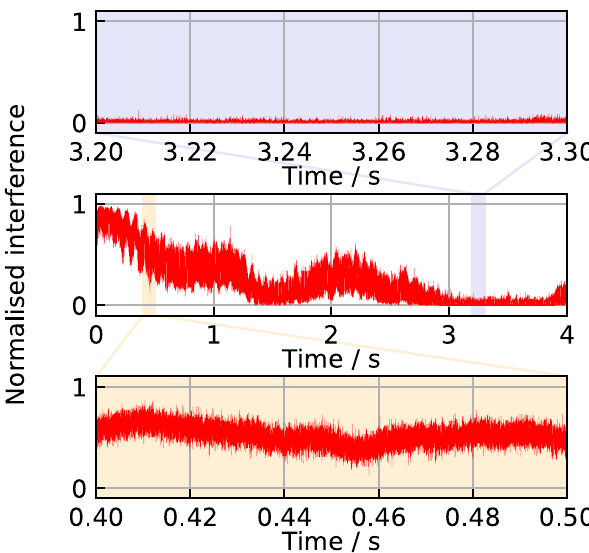
Fig. 5 QKD lasers interference on the long term. In the central panel, the normalized interference pattern in the stabilized- fi ber condition is shown in a 4 s-long time window. The shadowed area zoomed in the uppermost panel indicates a 100 ms-long fraction of the time interval in which the interferometer operated in the maximum visibility condition, i.e., the one exploited for the exchange of the bits of the cryptographic key. The shadowed area zoomed in the lowermost panel indicates a 100 ms-long time interval in which the interferometer operated around the 0.5 visibility. Con fi gurations far from the deterministic behavior of the interferometer (i.e., far from the maximum and minimum of the visibility) are the ones where the relation between the phase fl uctuations and the QBER is linear, and could be used to realign the phase on the long term and mitigate the residual uncontrolled optical path length variations (see Supplementary